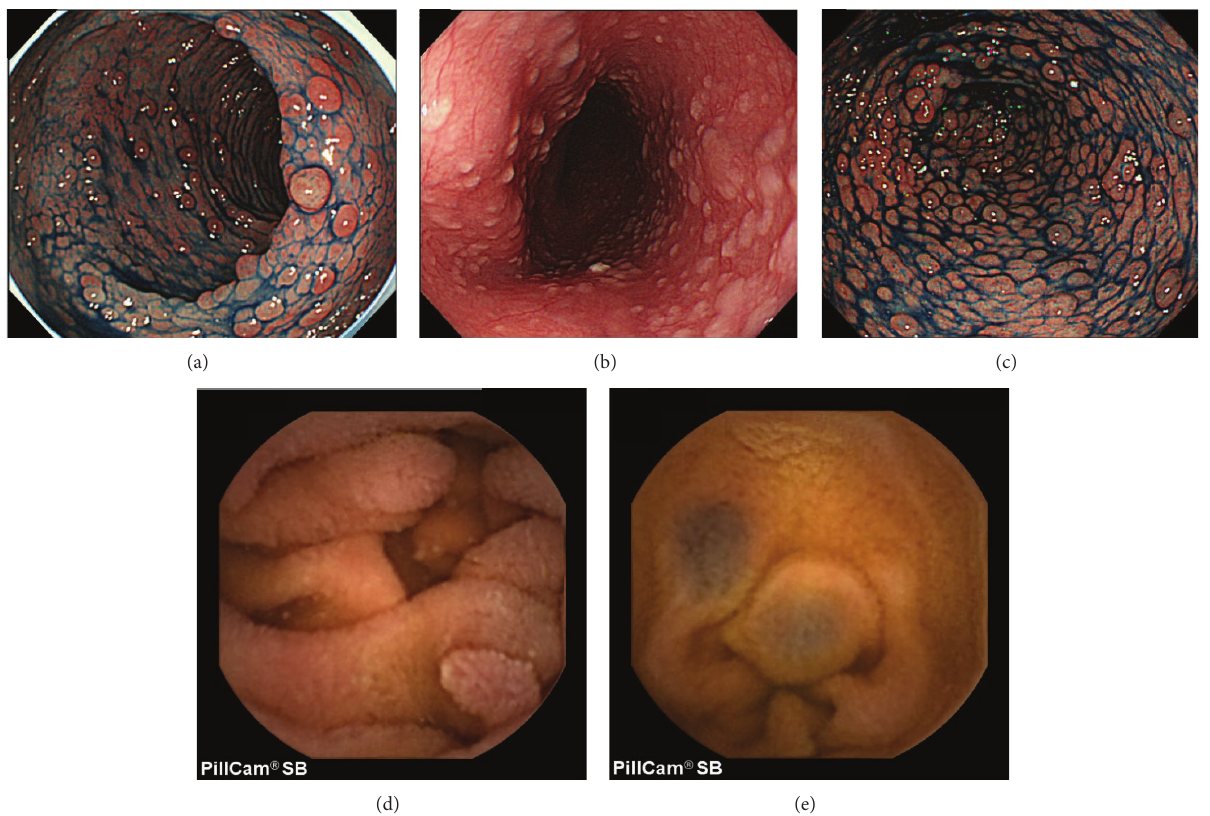
Figure 1: Endoscopic views of Case1. (a) Colonoscopy revealed multiple rectal polyps. (b) Esophagogastroduodenoscopy (EGD) showed whitish polypoid lesions in the esophagus. (c) EGD showed multiple gastric polyps. (d) Capsule endoscopy revealed multiple polypoid lesions similar in color to the surrounding mucosa in the jejunum, with their diameters of 2–5 mm. (e) Capsule endoscopy revealed hemangiomas in the